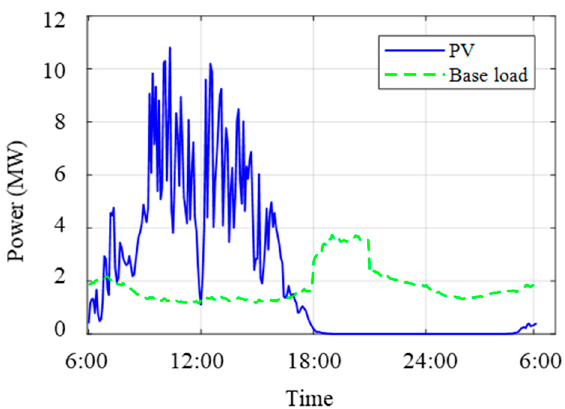
Figure 8. IEEE 33-node power distribution system.